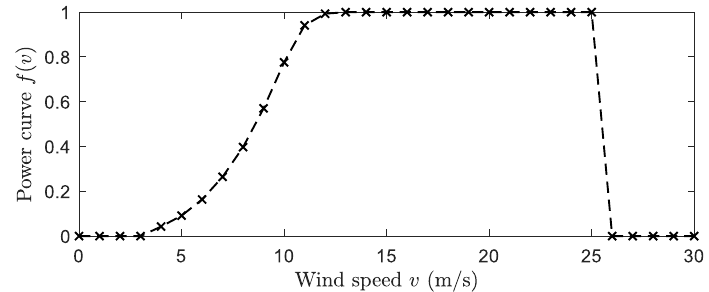
Figure A2. Normalized power curve function used for the wind power case study.